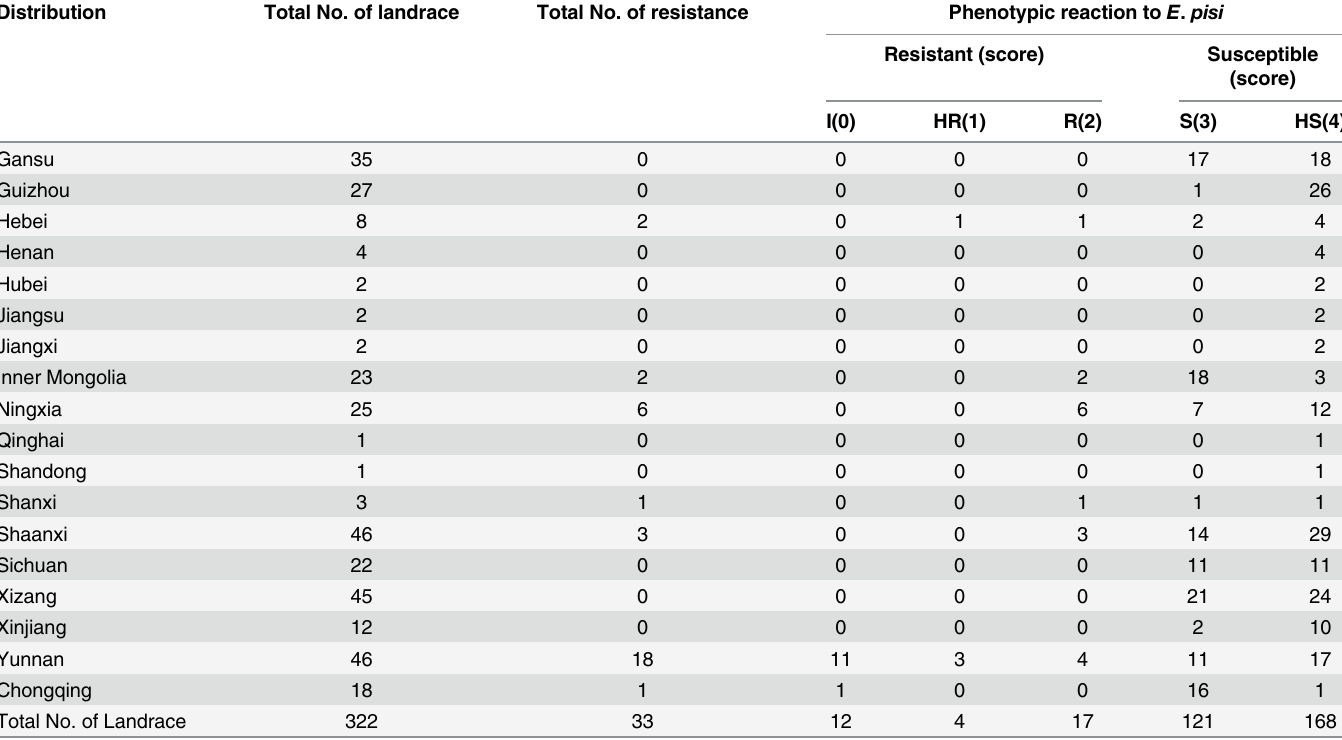
Table 1. Geographical distribution of 322 Chinese pea landraces and their phenotypic reaction to E . pisi isolate EPYN.